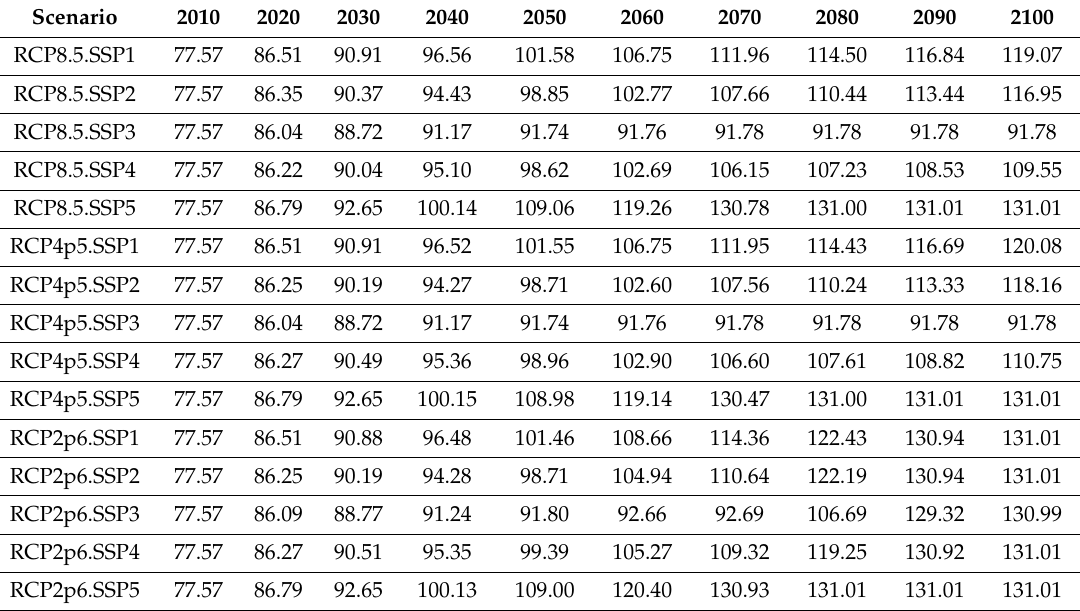
Table A8. Total national harvest (millions of m 3 / year, excluding bark, harvesting losses and branches).